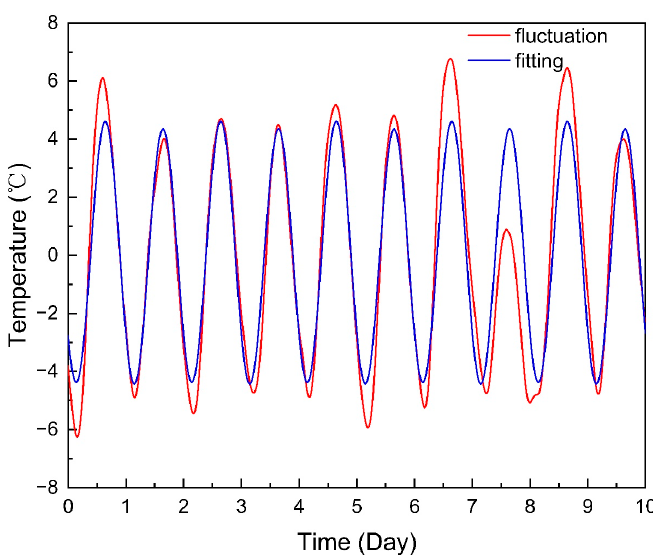
Figure 11. Subitem fitting.